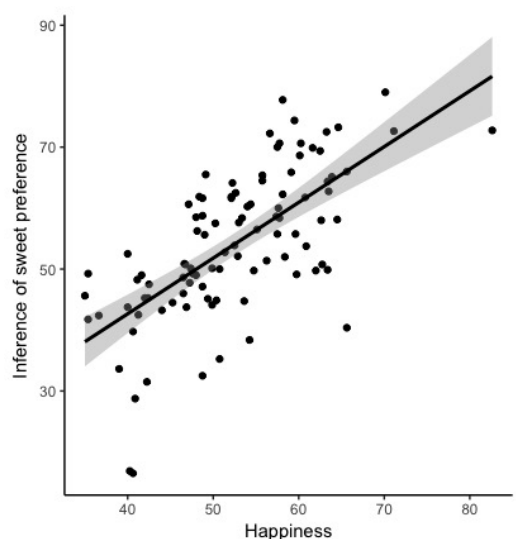
Figure A1. Scatterplot of the relationship between perceived obesity and inferences of sweet preference.